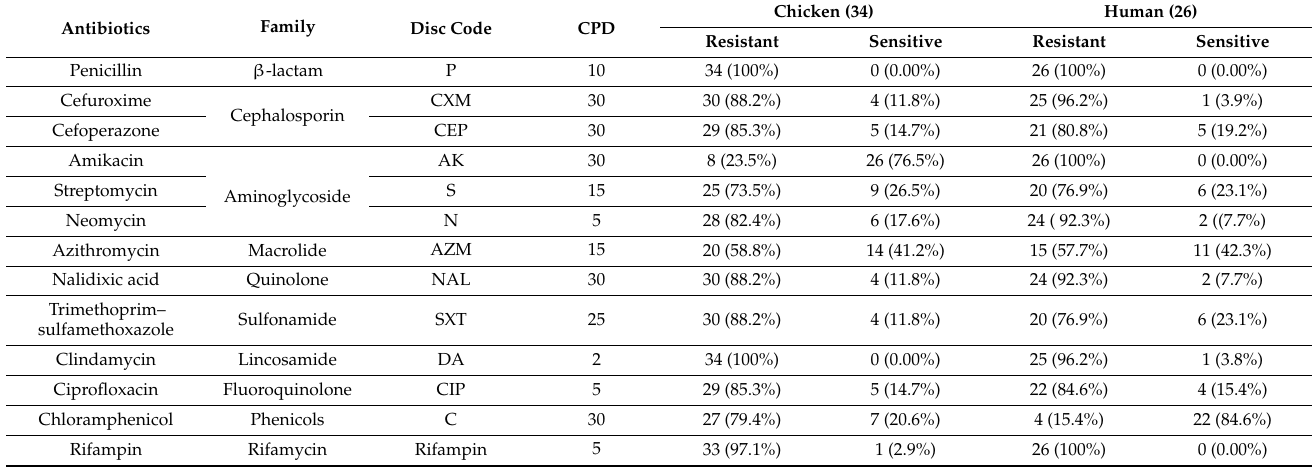
Table 4. Results of antimicrobial susceptibility testing for the examined E. coli isolates.